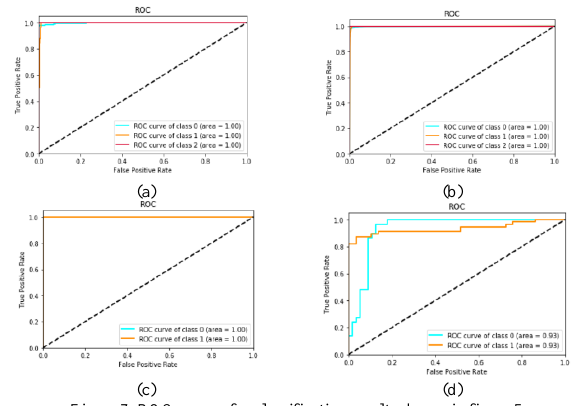
Figure 7: ROC curves for classification results shown in figure